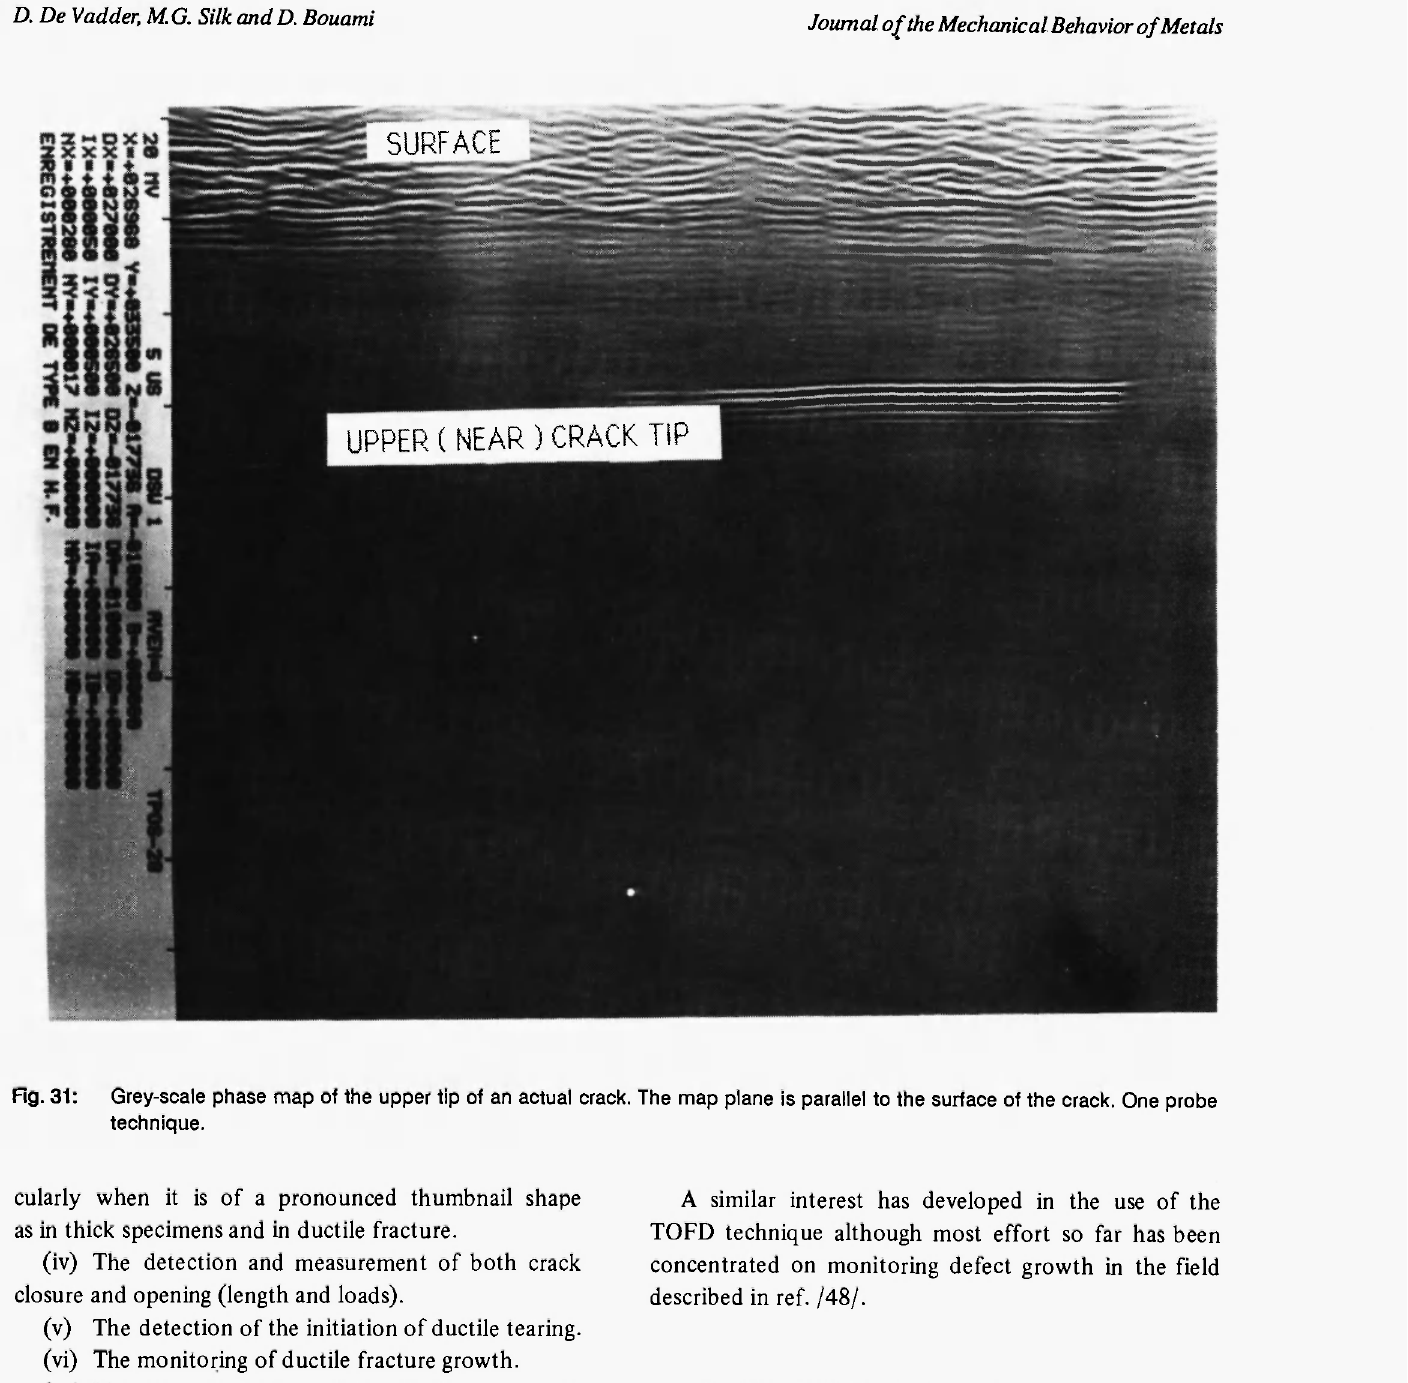
cularly when it is of a pronounced thumbnail shape as in thick specimens and in ductile